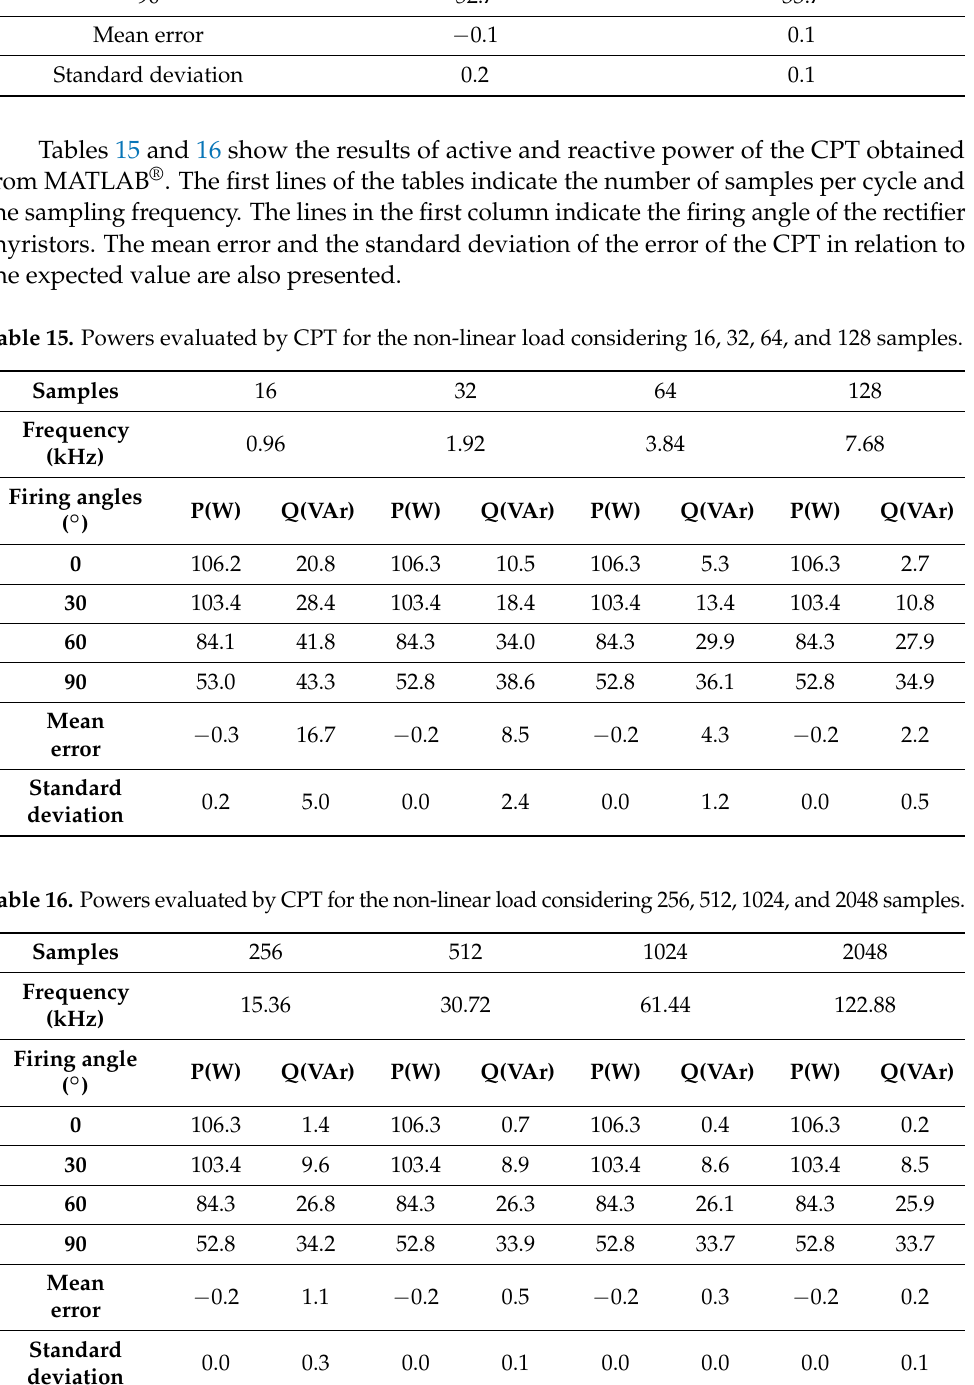
Table 15. Powers evaluated by CPT for the non-linear load considering 16, 32, 64, and 128 samples. Samples